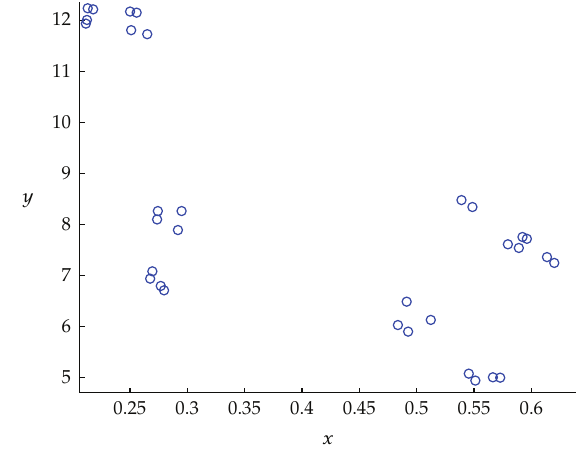
Figure 14: A stable 32-cycle for a (cid:8) 4 . 7071, b (cid:8) 0 . 2, and d (cid:8) 2 .